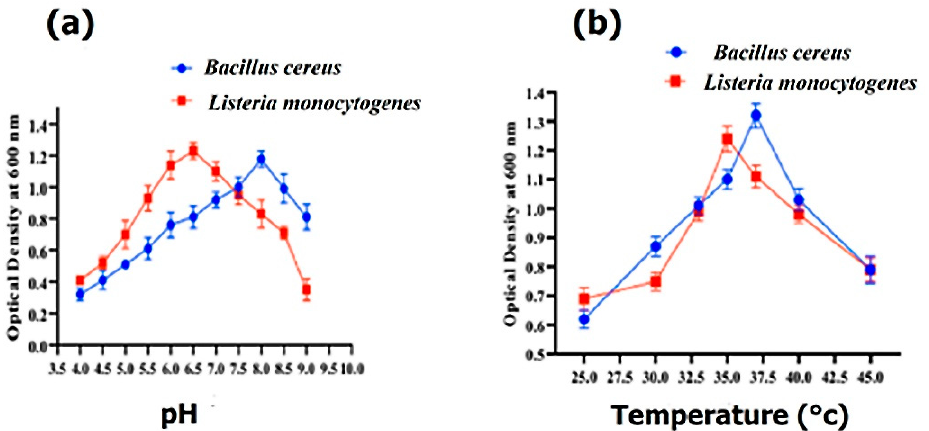
Figure 3. The effect of pH on the growth of Bacillus cereus and Listeria monocytogenes ( a ) and the effect of temperature (°C) on the growth of Bacillus cereus and Listeria monocytogenes ( b ).